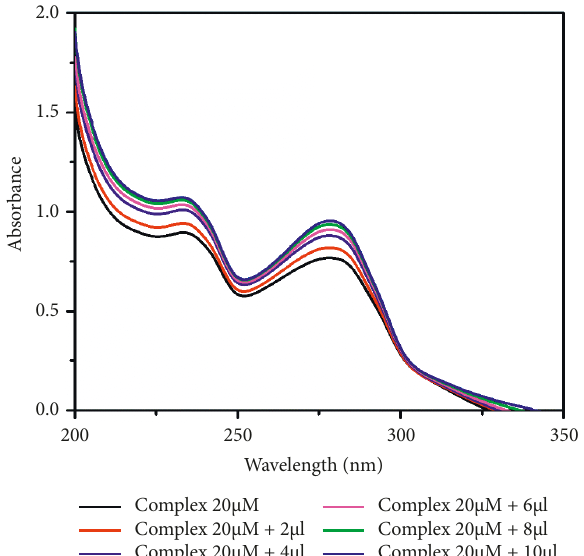
Figure 2: UV-absorption titration of complex 1 (20 µ M) with 0.2 mM CT-DNA in 10 mM Tris-HCl buffer (pH 7.2).